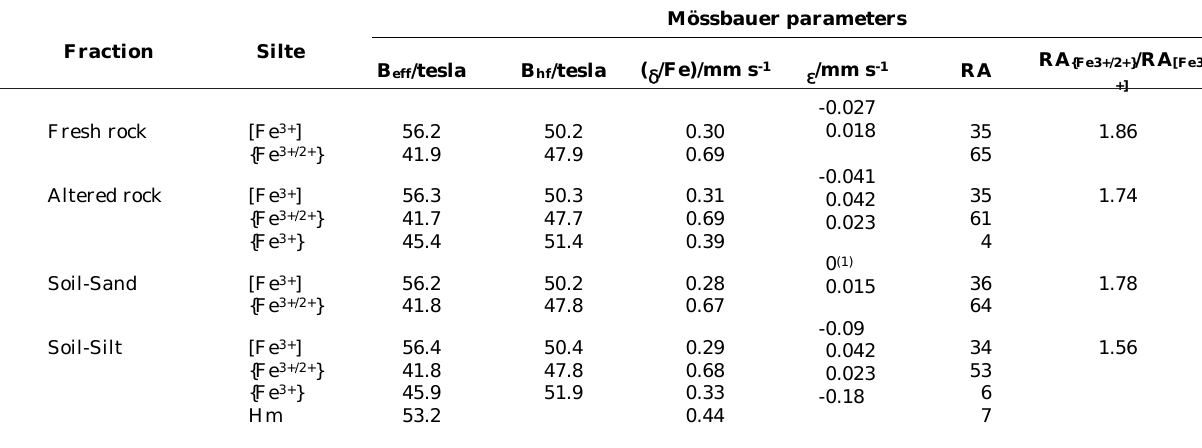
Mössbauer parameters